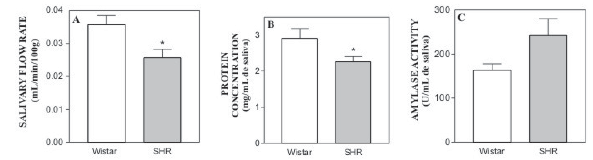
FIGURE 3- Salivary flow rate (A), salivary protein concentration (B) and salivary amylase activity (C) in the saliva of Wistar offspring (n=8) and SHR offspring (n=15). The bars represent the mean ± SEM of salivary flow rate, salivary protein concentration and salivary amylase activity in the saliva of evaluated offspring.